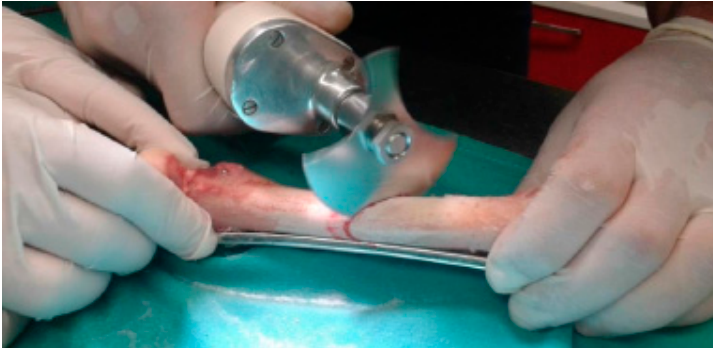
Biology 2022 , 11 , x Figure 3. Fabrication of the oblique fracture. Figure 3. Fabrication of the oblique fracture. Figure 3. Fabrication of the oblique fracture.